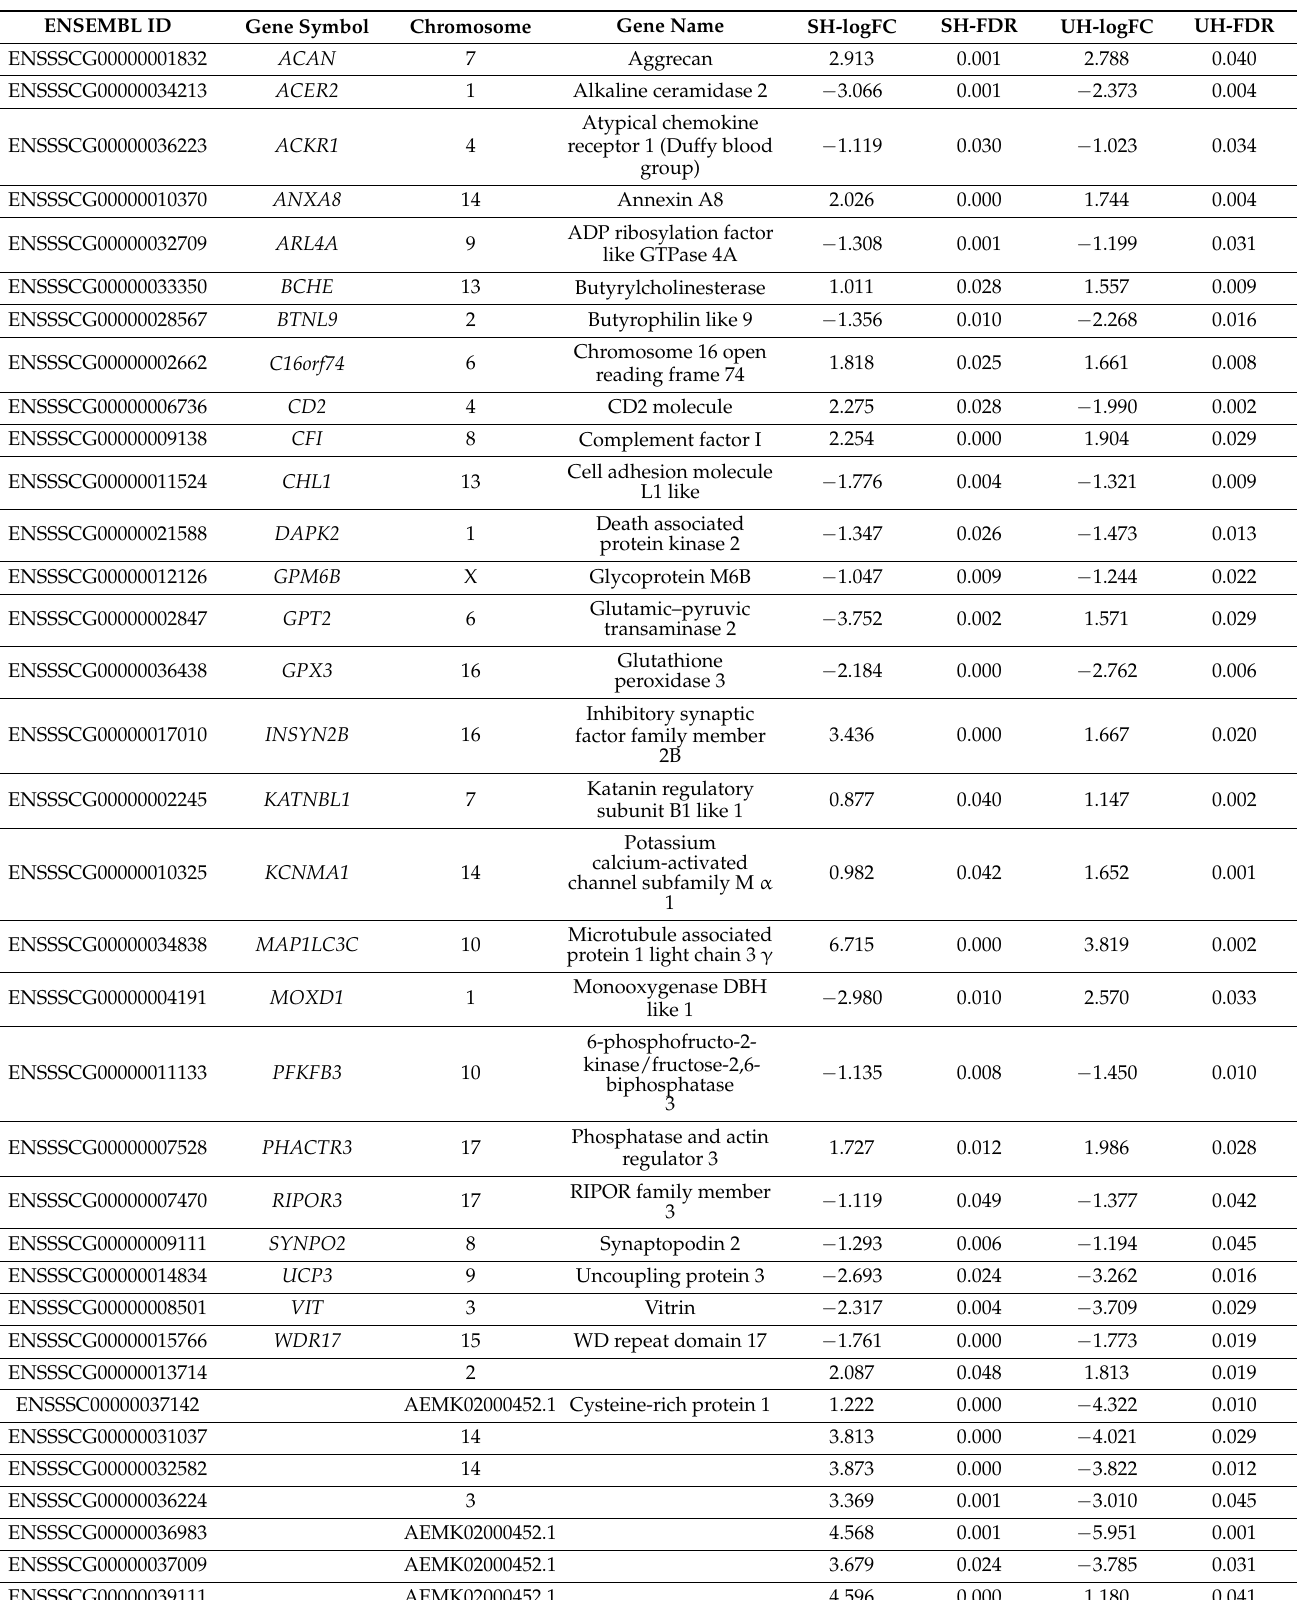
Table 2. Differentially expressed genes identified in both scrotal (SH) and umbilical hernia (UH)